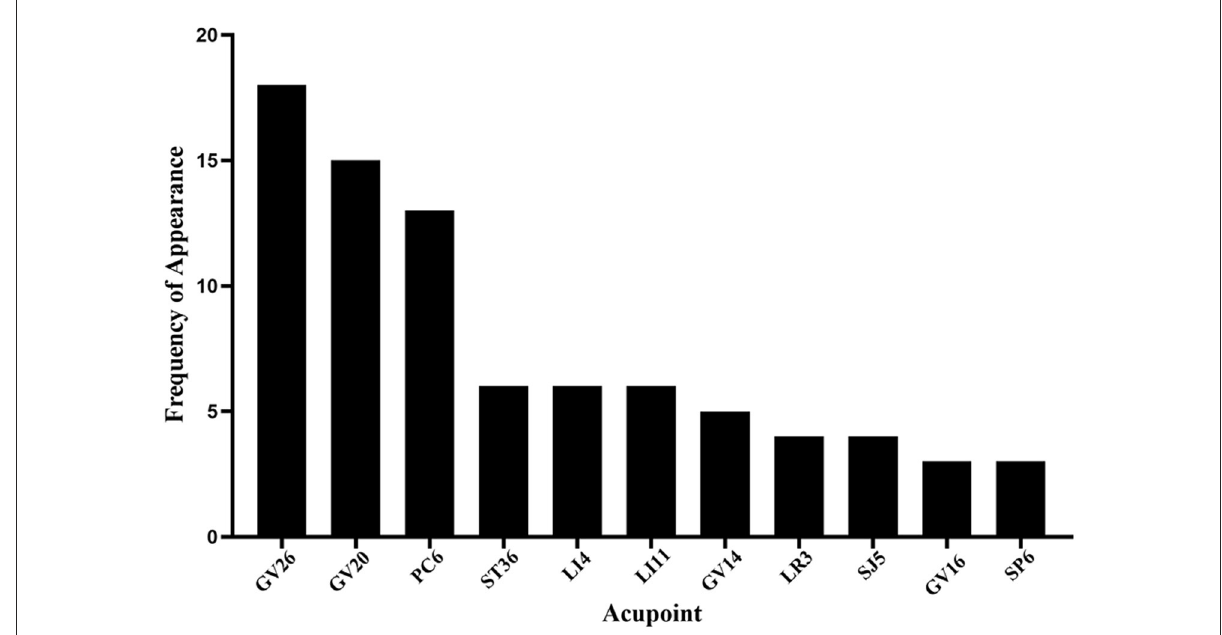
FIGURE4 Frequency summary of individual acupoint. Only the acupoint that appears more than twice is shown. GV26: Shuigou; GV20: Baihui; PC6: Neiguan; ST36, Zusanli; LI4: Hegu; LI11: Quchi; GV14: Dazhui; LR3: Taichong; SJ5: Waiguan; GV16: Fengfu; SP6: